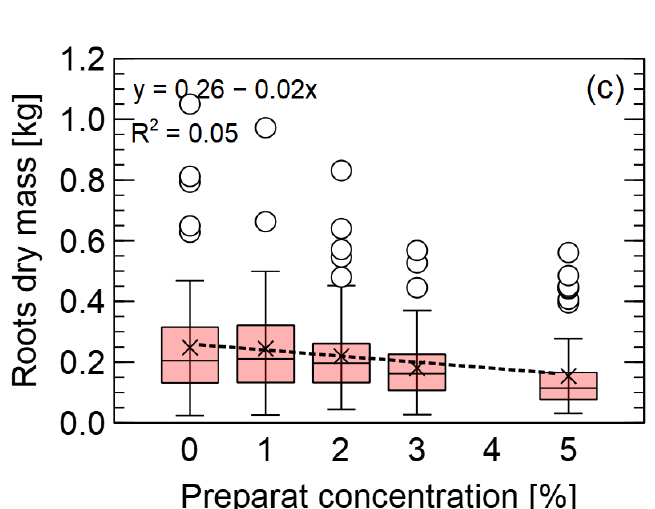
Figure 5. Pines’ roots length ( a ), width ( b ), and dry mass ( c ), versus silicon concentration, measured after finishing the experiment. In sub-Figure ( c ), the dashed curve represents the linear regression fit of the data. The regression equation with the fitted parameters and the model’s R 2 values are printed. The regression parameters are statistically significant at p < 0.0001. For the case presented in sub-Figures ( a , b ), the regression parameters were not statistically significant at the p -value level of 0.05, thus, the fits are not presented. In the plot, boxes span from the 1st to 3rd quantile, with the median indicated by a line, whiskers indicating a 1.5 inter-quantile range, the × symbol indicating the mean value, and circles indicating outlier